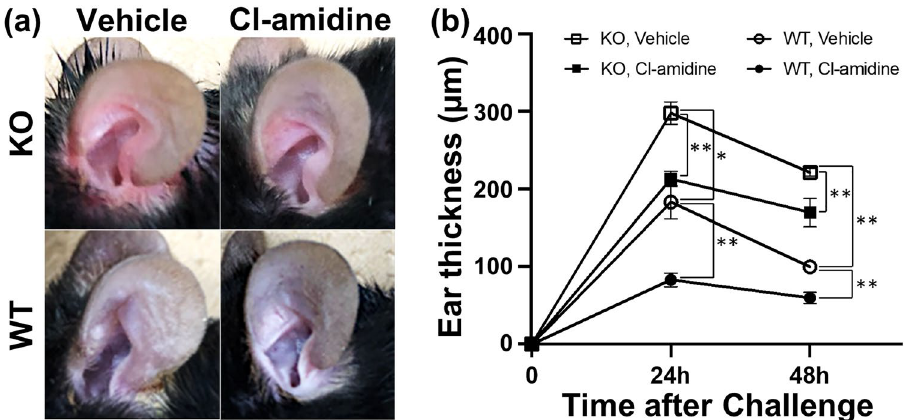
Figure 1. Effect of Cl-amidine on the contact hypersensitivity response in wild-type mice (WT) and Il36rn −/− mice (KO). ( a ) Representative images of the ear tissues of KO and WT treated with Cl-amidine (10 mg/kg/ day) or vehicle 48 h after the DNFB challenge. ( b ) Measurement of ear thickness in KO and WT treated with Cl-amidine (10 mg/kg/day) or vehicle 24 h and 48 h after the DNFB challenge. All values represent the mean ± SEM obtained from six mice per group. (* p < 0.05, ** p <